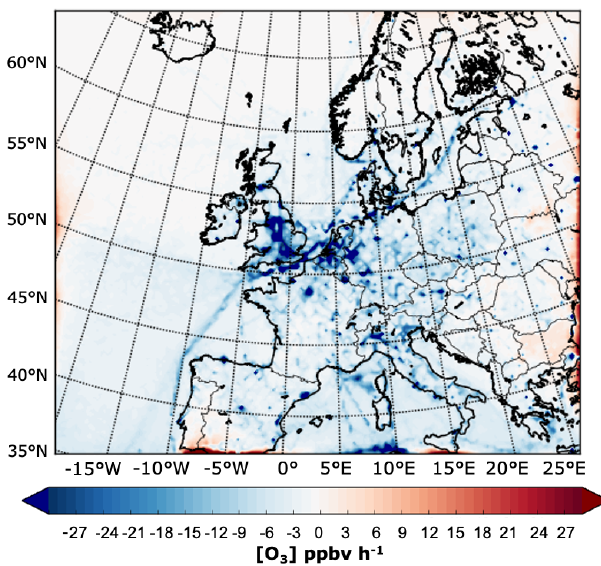
Figure 6. Net midday (11:00–14:00UTC) near-surface lateral- boundary O 3 chemical production rate in ppbvh − 1 in July 2015. Note that O 3 production is driven by tagged LB NO x that has en- tered the model domain via the lateral